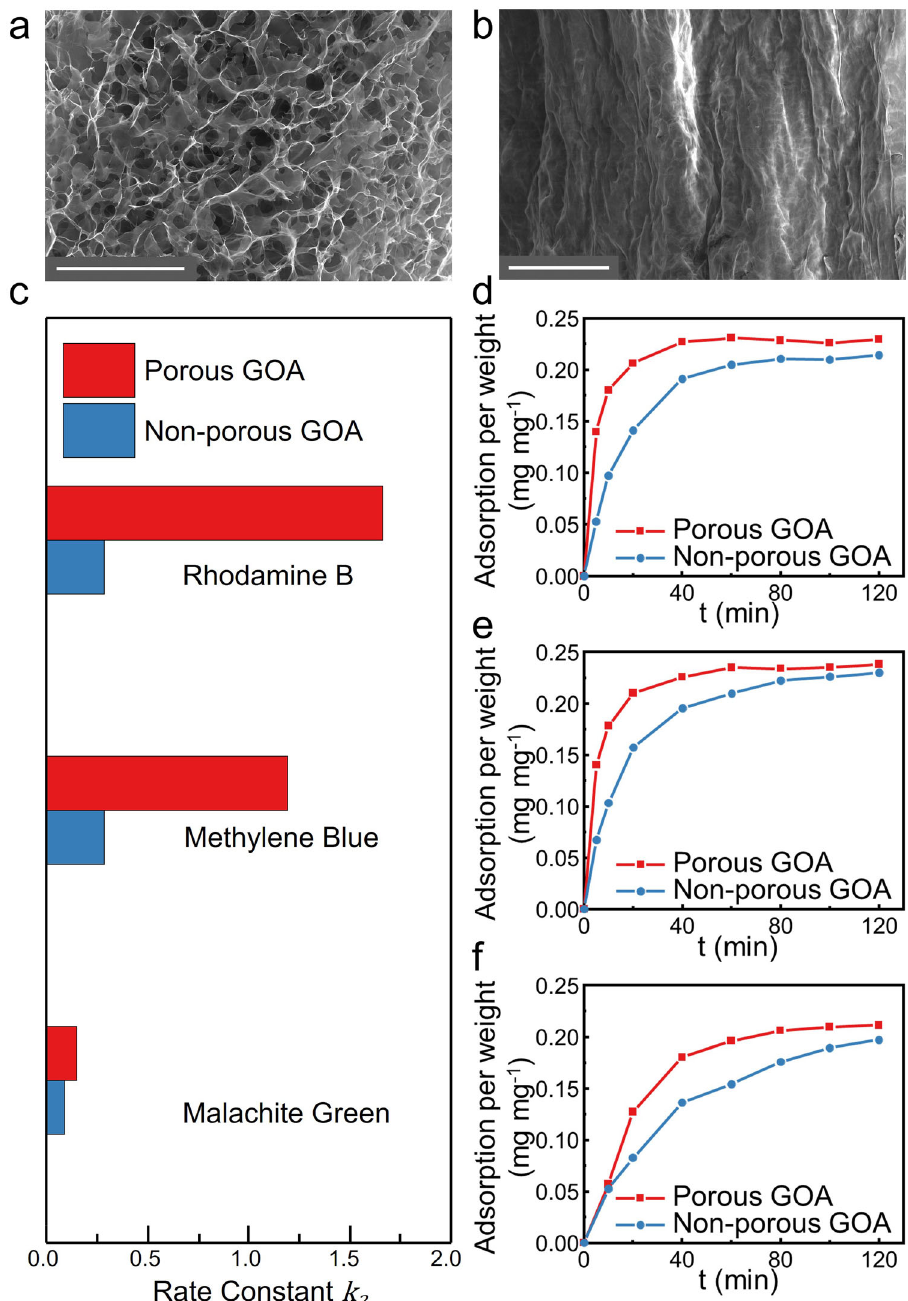
curves of porous GOA and non-porous GOA in ( b ) rhodamine B, ( e ) methylene blue, and ( f ) malachite